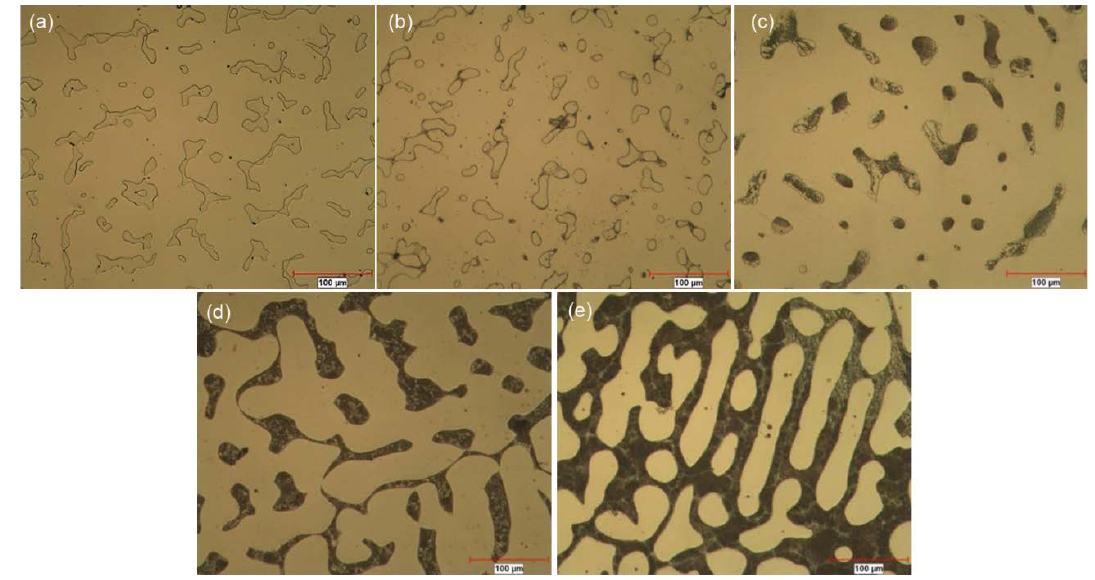
Figure 2. Microstructures of the heat treated alloys with ( a ) 0B, ( b ) 0.06B, ( c ) 0.25B, ( d ) 0.5B, and ( e ) 1B. The images were taken at 200×.